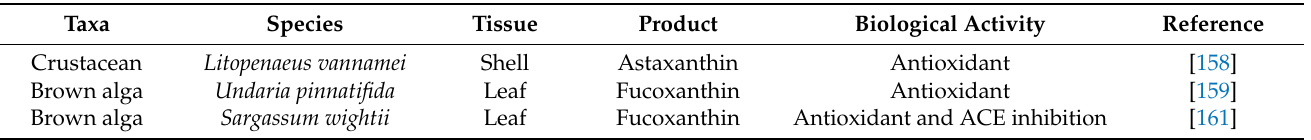
Table 5. Carotenoids from seafood wastes, together with taxa, species and tissue from which they were isolated, and their biotechnological